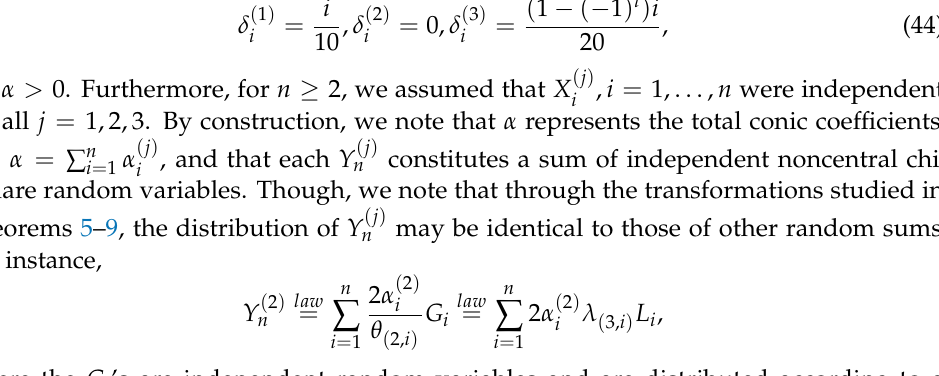
Figure 1. The values of the parameters set in Example 1, in which we plotted c j ν factor 0 < c j < 1 to make its scale comparable to the other parameters for all j =